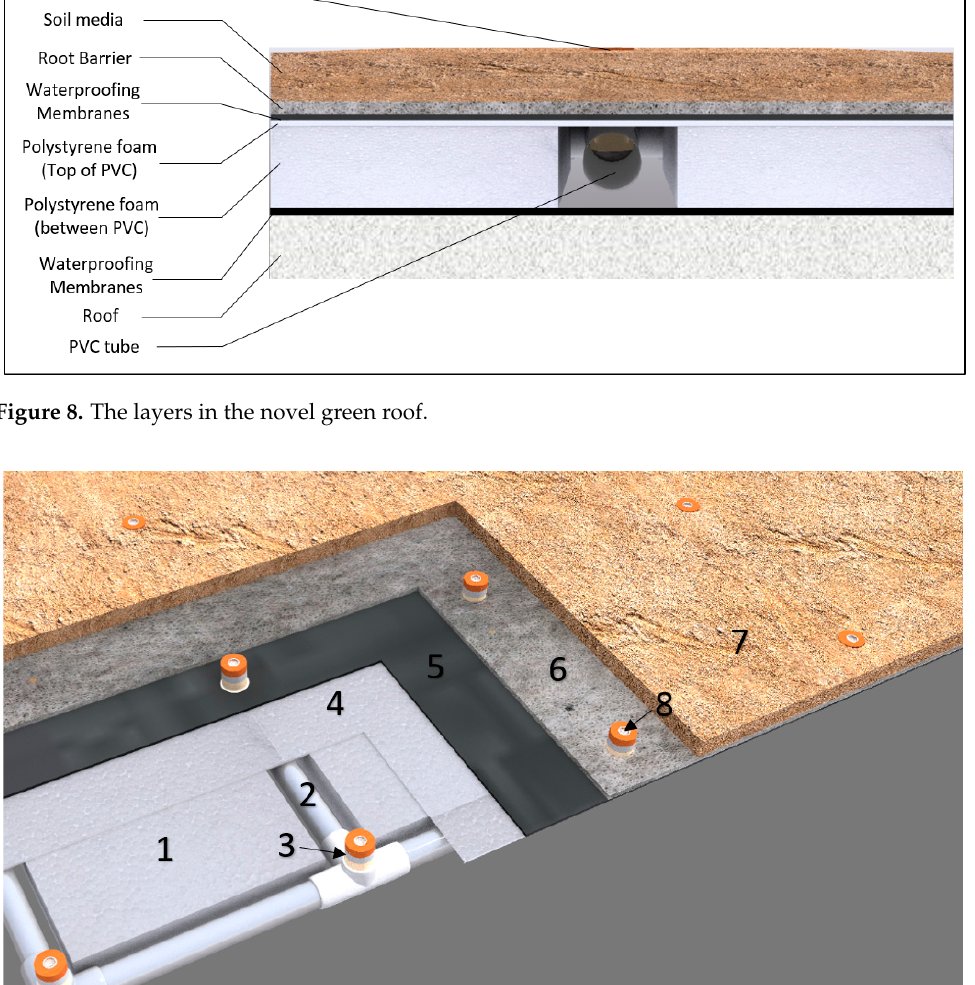
Figure 9. Details of all layers. (1) Polystyrene foam; (2) PVC tube; (3) multilayer filter; (4) 1 cm of polystyrene foam; (5) waterproofing membrane; (6) root barrier layer; (7) soil media; (8) drain filters.